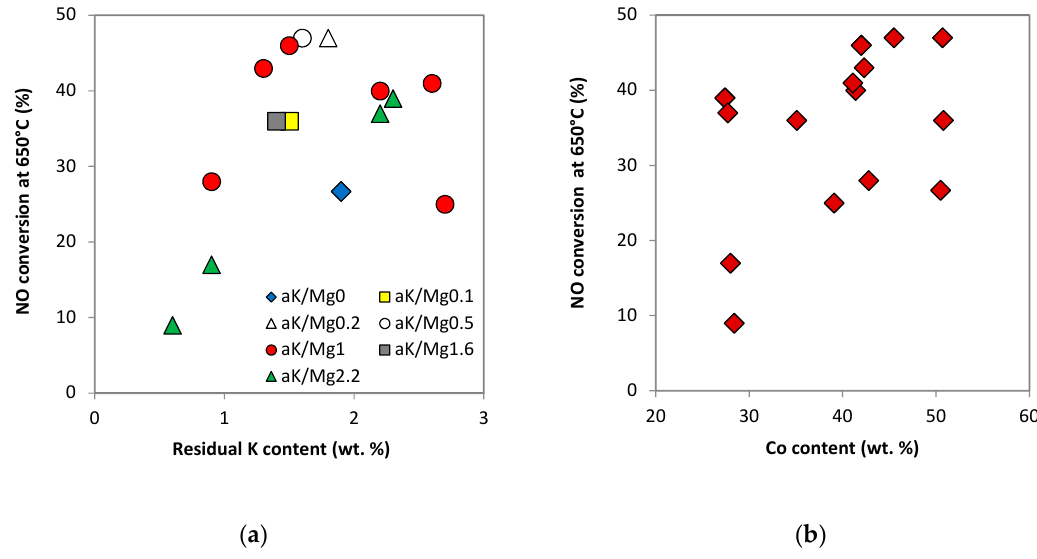
Figure 15. Dependence NO conversion on: ( a ) residual (real) potassium content and ( b ) cobalt content.